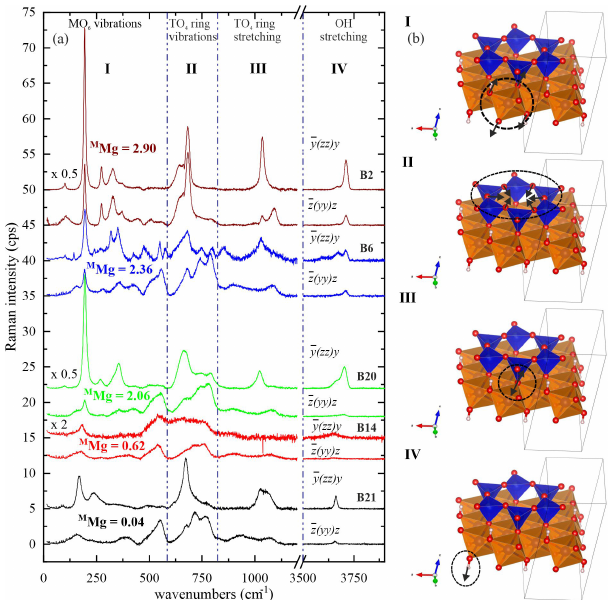
Figure 4. (a) Raman spectra of selected biotite samples with in- creasing octahedrally coordinated Mg content in atoms per for- mula unit from bottom to top. Spectra with the same color refer to the same sample and were measured in horizontal and verti- cal parallel-polarized geometries. The spectra are vertically offset for clarity. (b) Sketches illustrate the type of dominating atomic displacements within each spectral range (I–IV). VESTA software package (Momma and Izumi, 2008) was used to plot the atomic